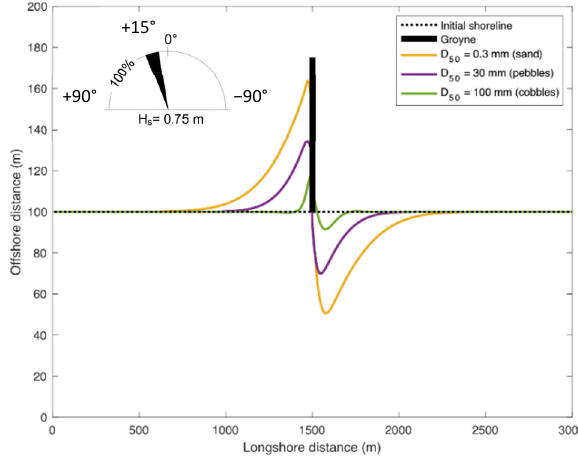
Figure 6. Calculated shoreline evolution for D n 50 = 0.3 mm, 30 mm, 100 mm.